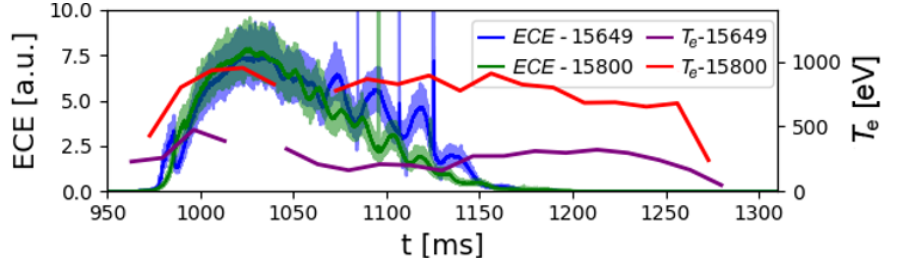
Figure 6. Comparison of the V-ECE measurement and Thomson scattering T e at the resonance region of the ordinary B = 1 . 15 T (#15649) and high-field B = 1 . 50 T (#15800) discharge. O-mode, channel 1 = 76.5 GHz: (O,ch1). Pale colour : raw signal; Rich colour : smoothed signal. t > 1150: overdense ⇒ cuto ff .